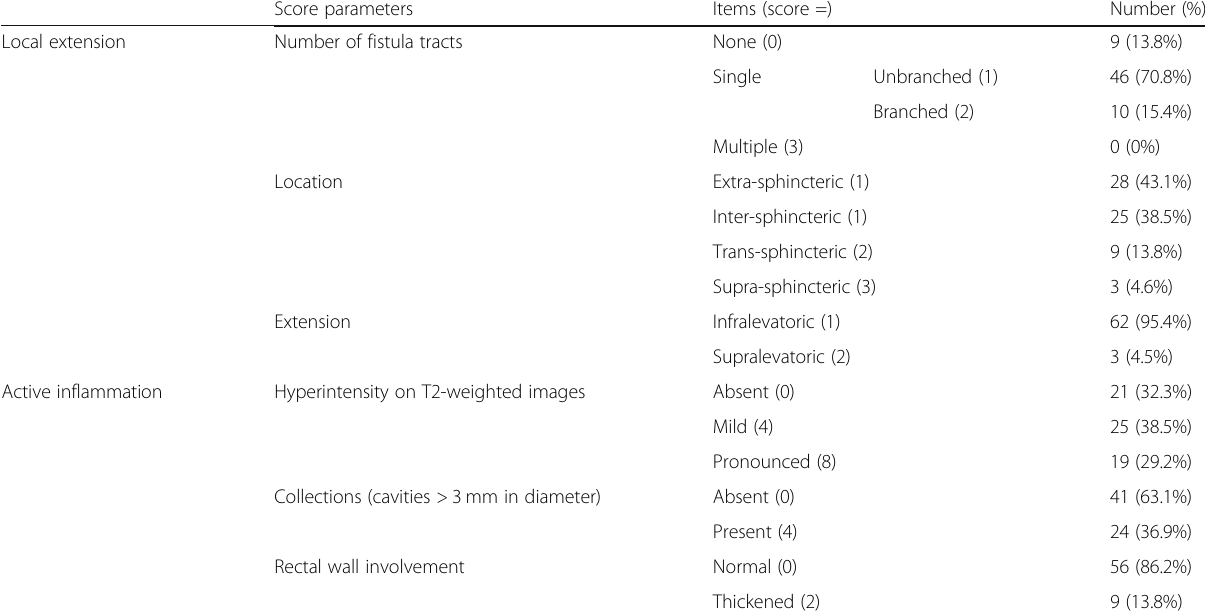
Table 3 MRI findings according to Van Assche scoring system